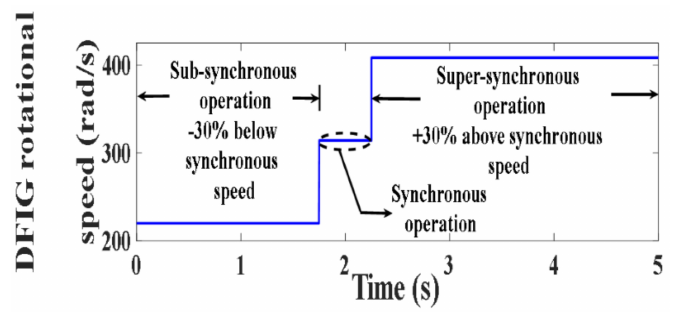
Figure 77. Prime mover operating speeds